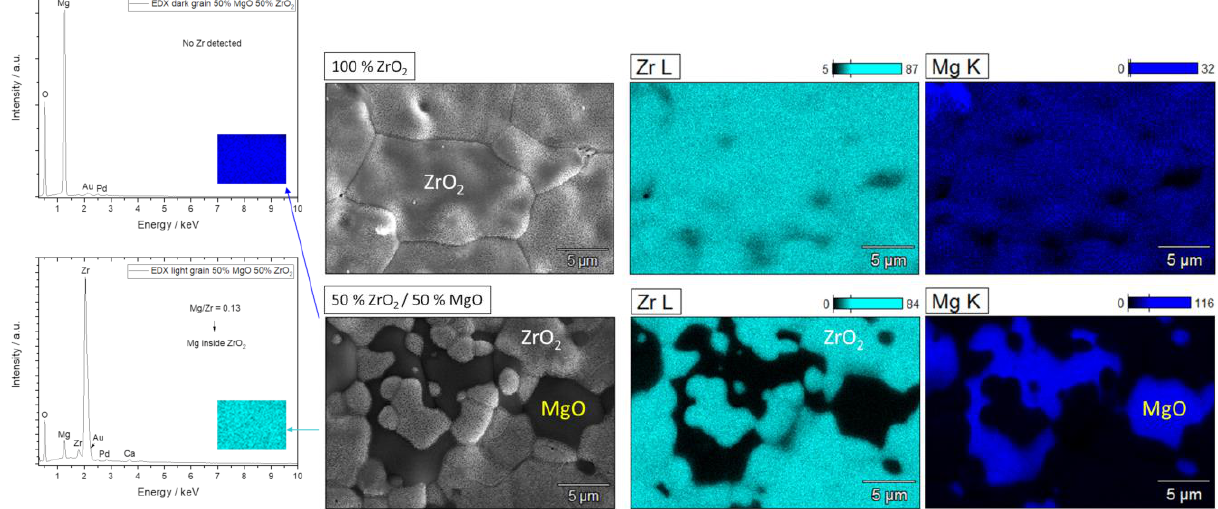
Figure 2. Representative EDX mapping of pure 100% ZrO 2 ( top ) with a homogeneous distribution of Zr/Mg inside the grains and mixed 50% ZrO 2 / 50% MgO ( bottom ) ceramics with well detectable ZrO 2 (Mg is incorporated) and MgO grains.